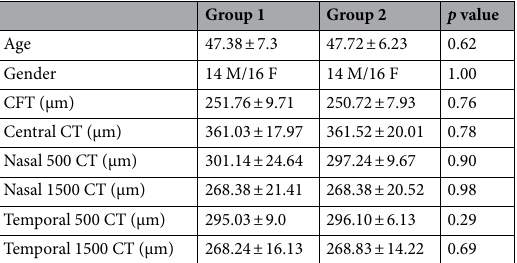
Table 1. Age, gender, central macular thickness, coroidal thickness and p value of the study groups. (M: Male, F: Famale, CFT: Central Foveal Thicknesss, CT: Coroidal thickness).